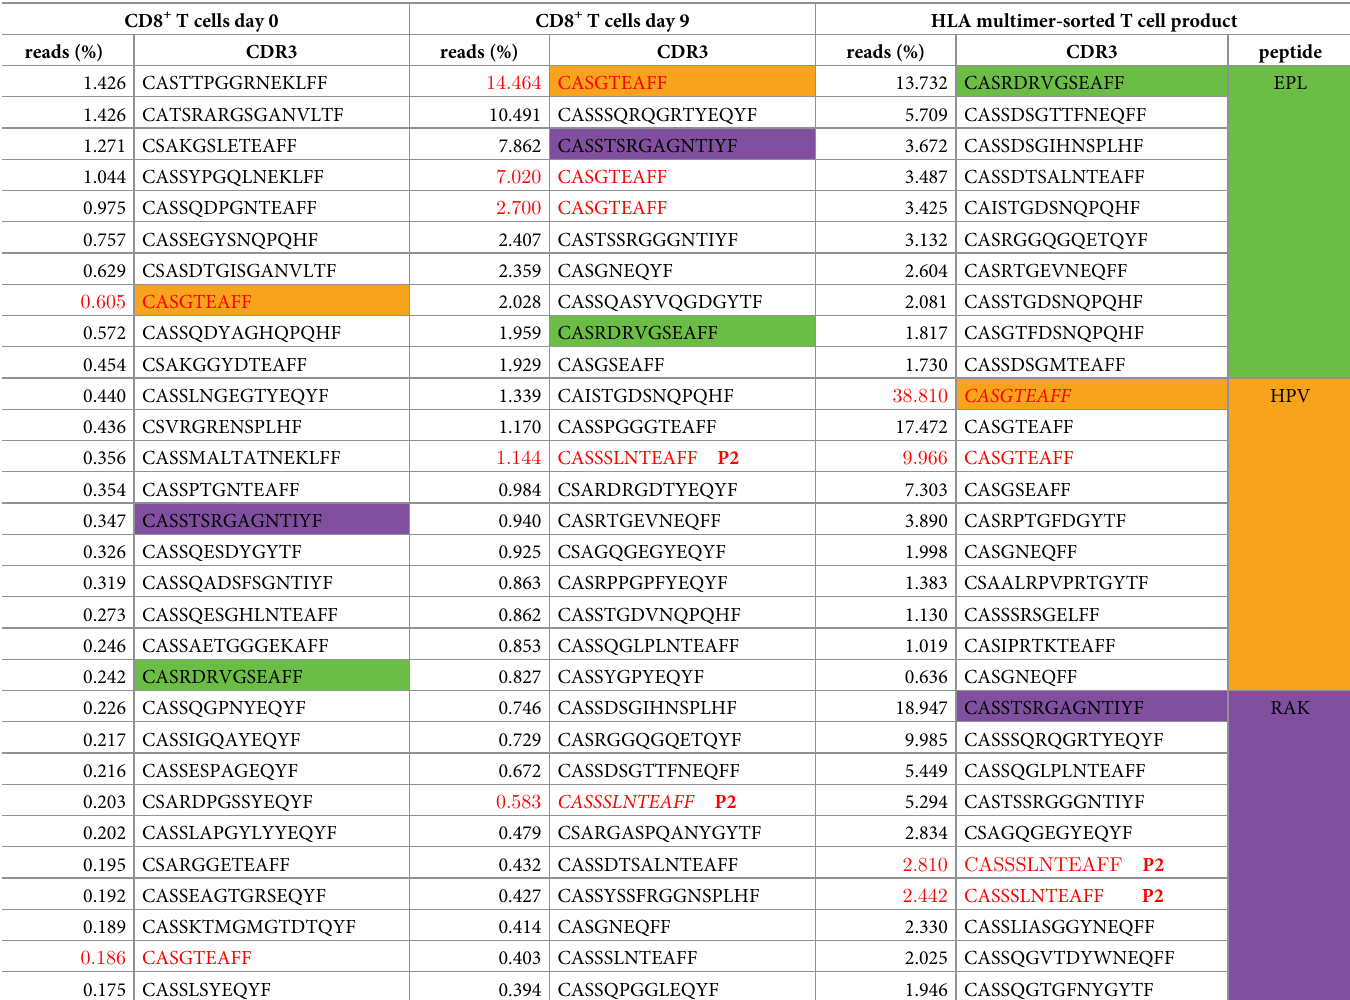
Table 2. Expansion of distinct clonotypes after EBV-derived peptide